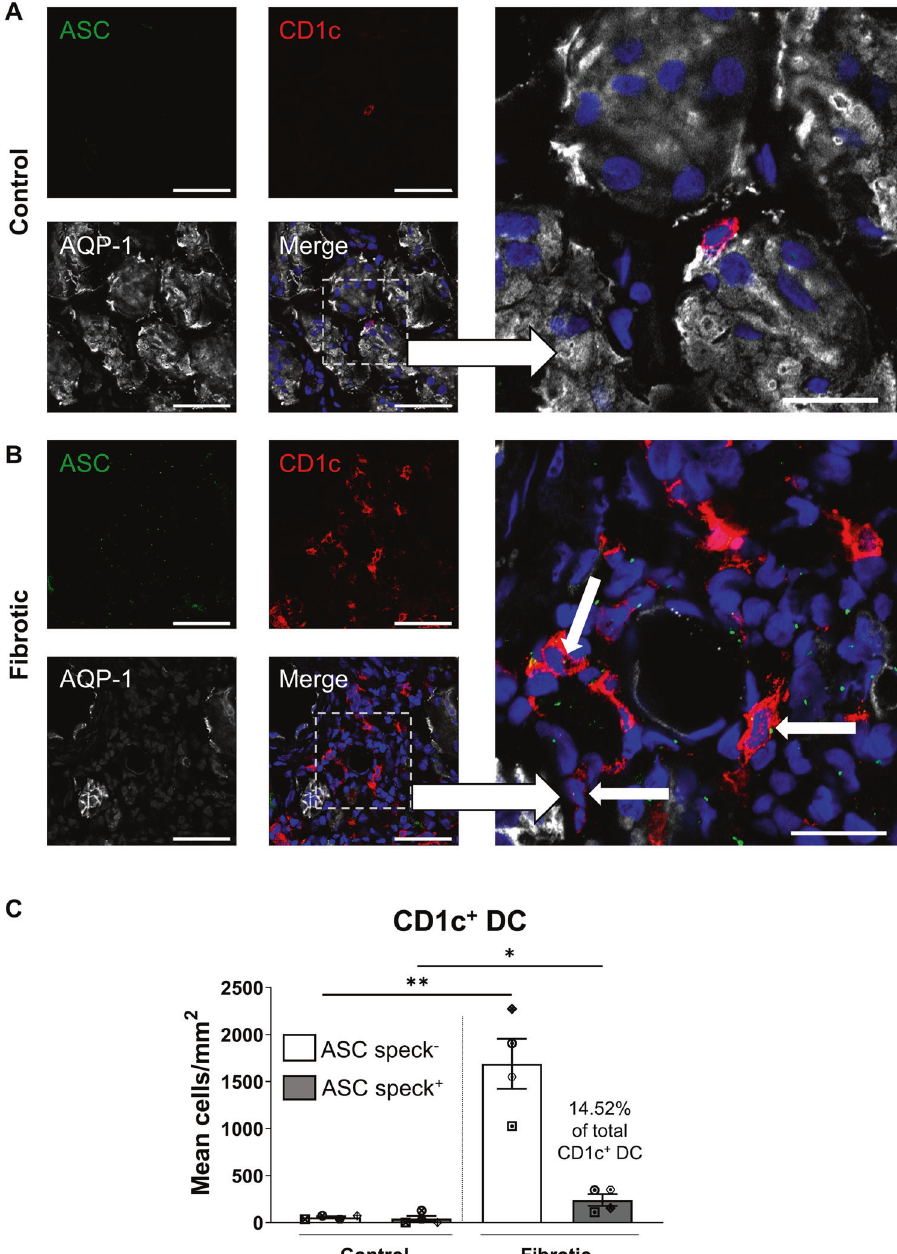
Fig. 6 Signi fi cantly elevated tubulointerstitial CD1c + DC with ASC specks in fi brotic kidney tissue. A , B Immuno fl uorescent labelling of frozen sections from control/non- fi brotic ( A ) and fi brotic kidney tissue ( B ) stained for ASC (green), CD1c (red), aquaporin-1 (AQP-1) (white) and DAPI (blue). Scale bars represent 50 µm for small frames (left panels) and 20 µm for large frames (right panels). ASC-speck-positive CD1c + DC are highlighted with white arrows. C Quanti fi cation (mean cells/mm 2 ) of ASC-speck-negative CD1c + DC (white bars) and ASC-speck-positive CD1c + DC (grey bars) in control/non- fi brotic kidney tissue ( n = 4) and fi brotic kidney tissue ( n = 4). Symbols represent values for individual donor tissue. Results represent mean ± SEM of values from fi ve randomly selected areas for each tissue sample. * P < 0.05, ** P < 0.01, Welch ’ s t on the Banff 97 working classi fi cation of kidney pathology [75]. Tissue specimens were grouped into ‘ control/non- fi brotic ’ ( n = 17; 4 female/13 male; mean age of 56.3 ± 11.5 years) or ‘ fi brotic ’ cortical tissue ( n = 5; 2 female/3 male; mean age of 54.4 ± 9.7 years) based on this histopatho- logical assessment of the non-tumour kidney parenchyma.